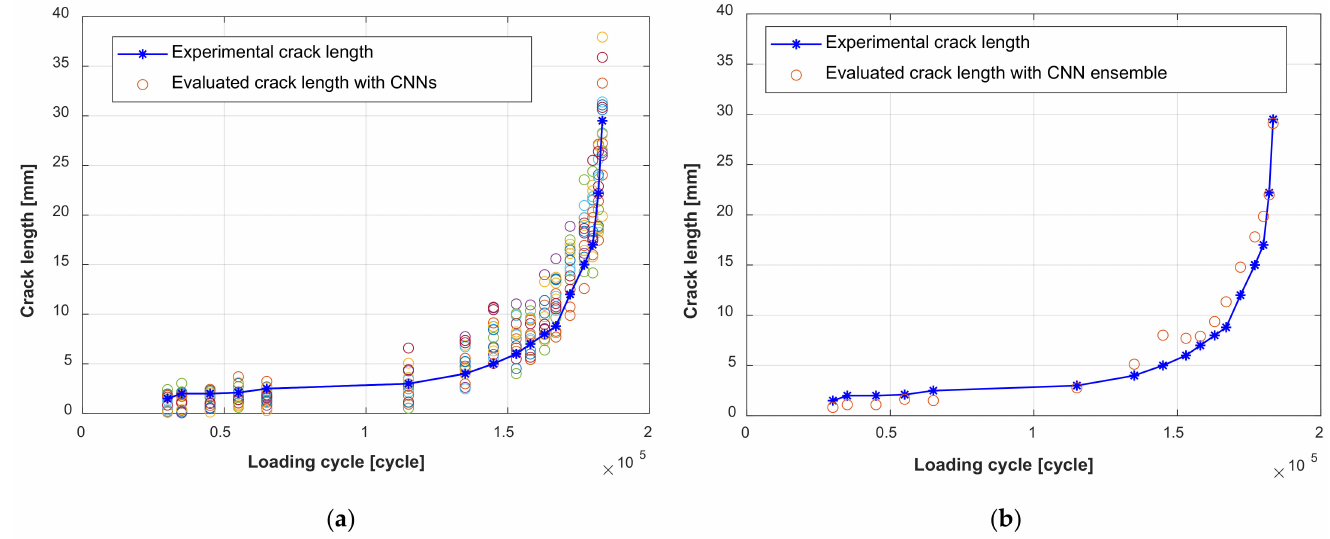
Figure 14. Fatigue crack evaluation result with the GW–CNN ensemble: ( a ) Output of the CNNs in the CNN ensemble; ( b ) Final output of the CNN